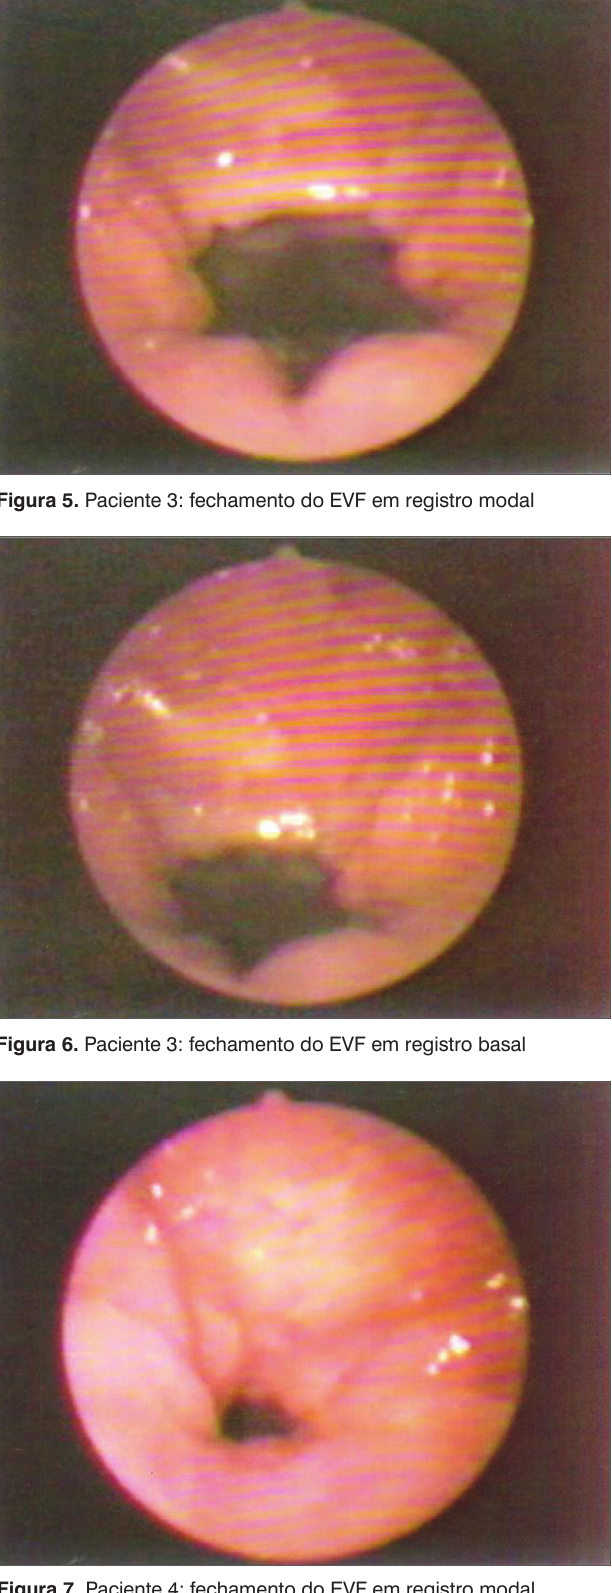
Figura 4. Paciente 2: fechamento do EVF em registro basal